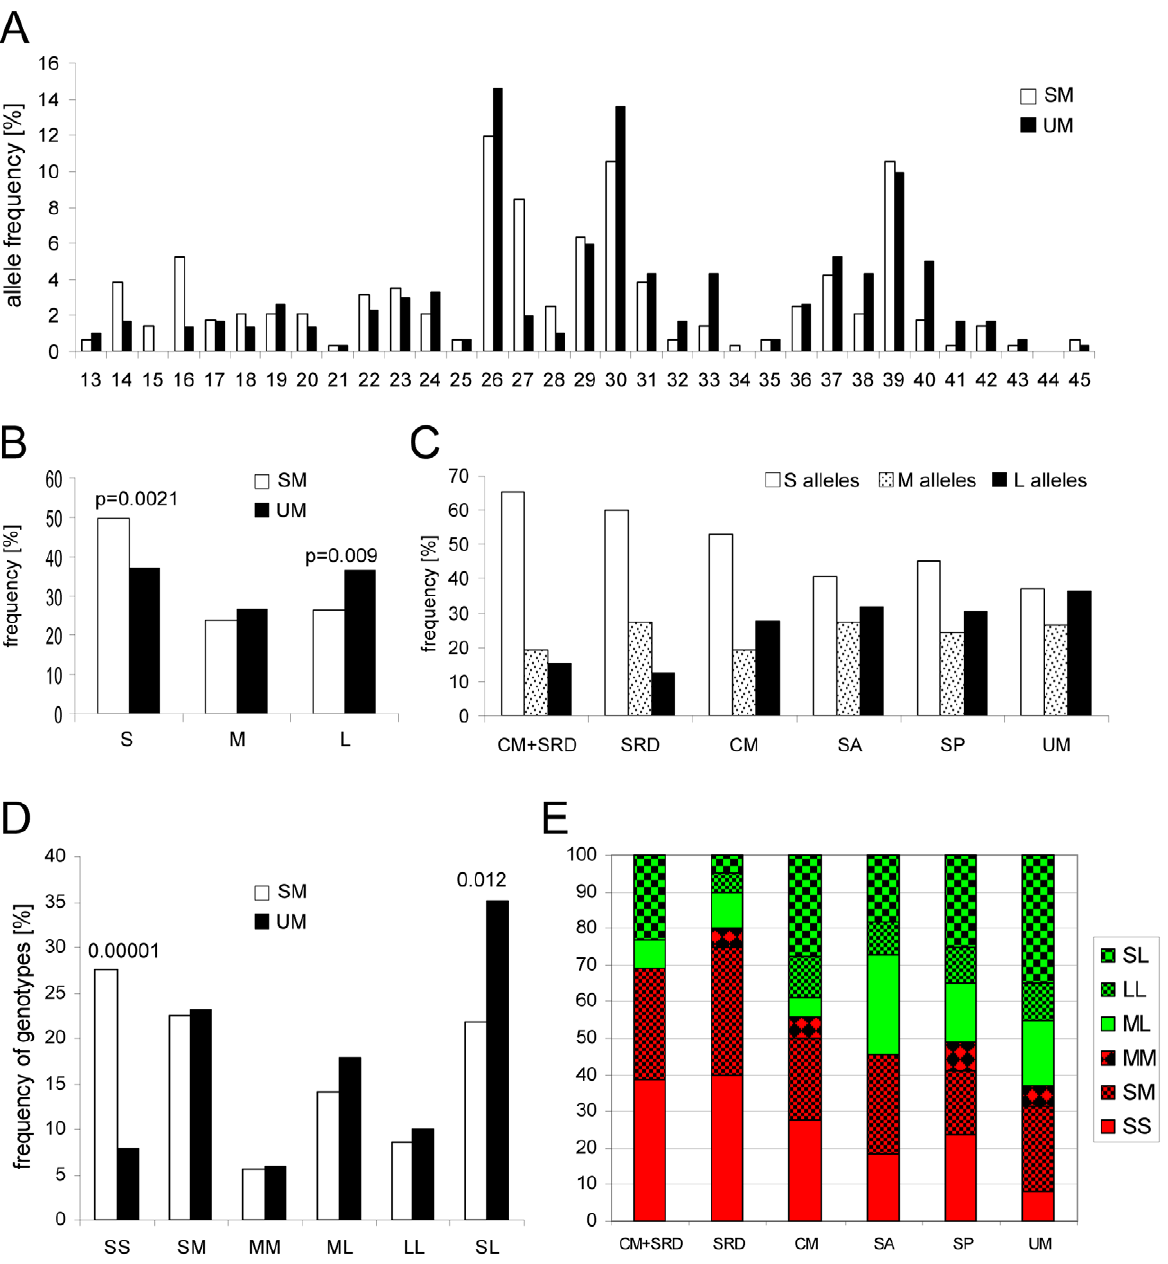
Figure 6. Long (GT) n repeats and ‘‘L carrier’’ genotype associate with less severe disease. A) Frequency distribution of the number of [GT] n repeats in SM (open bars, n=282 alleles) and UM cases (black bars, n=302 alleles). B) Frequency of the ‘‘S’’ (short , 27), ‘‘M’’ (medium 27 to 32) and L (long . 32) [GT] n repeats for SM (open bars) and UM (black bars) cases. C) Frequency of ‘‘S’’ (open bars), ‘‘M’’ (dotted bars) and ‘‘L’’ (black bars) [GT] n repeats according to disease entities. Distribution of HMOX1 promoter genotypes amongst D) SM (open bars) and UM (black bars) cases, and E) amongst different disease entities. Those labeled in green are ‘‘L carriers’’, those labeled in red are ‘‘non-L carriers’’. SM=severe malaria, SRD=severe respiratory distress, CM=cerebral malaria, SA=severe anaemia, SP=severe prostration, UM=uncomplicated malaria.